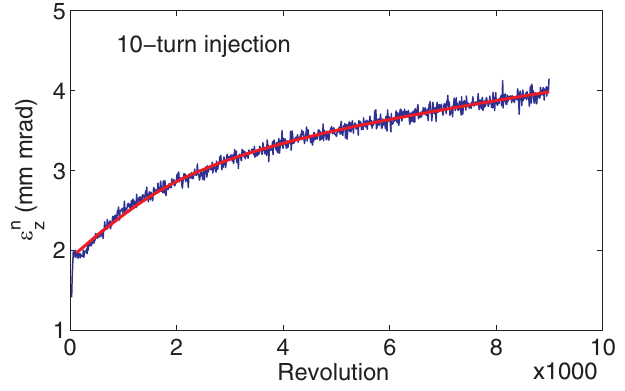
FIG. 11. (Color) A typical fitting curve of the model using Eq. (6) for the data set with 10-turn injection.